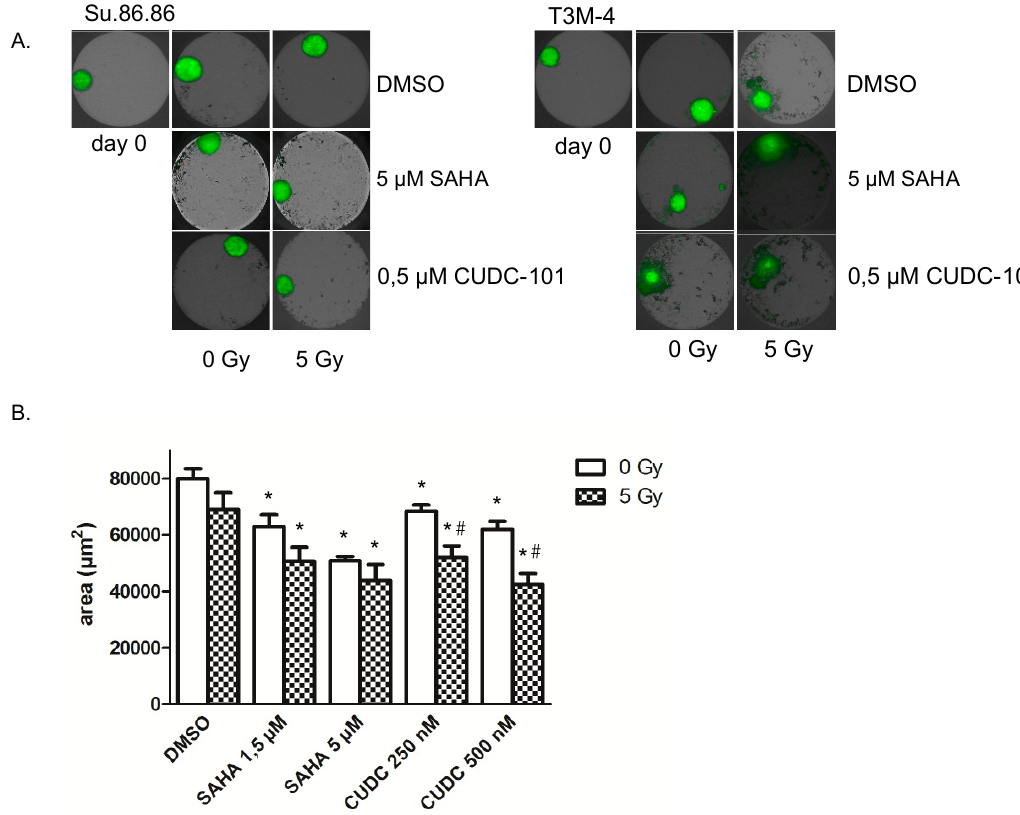
Figure 3. ( A ) Growth of 3D-microtissues was delayed after HDAC inhibitor and radiation treatment. Microtissues were grown from Su.86.86 (left) and T3M-4 (right) cells for 3 days, after that SAHA (1.5 and 5 µ M) and CUDC-101 (0.25 and 0.5 µ M) were added, another 24 h later cells were irradiated with 0 or 5 Gy. After 6 days pictures were taken with the high content screening system Operetta. ( B ) Areas of Su.86.86 microtissues were determined with the Operetta system. Data represent the mean of at least three independent experiment ± SD. For statistical analysis, ANOVA was performed with post hoc Bonferroni multiple comparisons. * Indicates comparison with DMSO control, p < 0.01, # indicates comparison between irradiated and non-irradiated CUDC-101 samples p < 0.05.